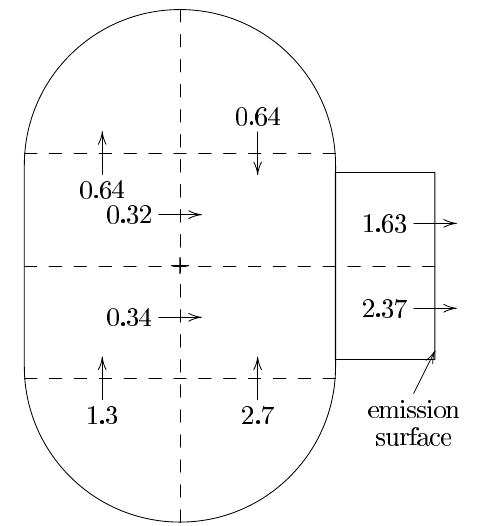
FIG. 8. Coarse-grained diagram of current flow in the cathode dome (units of kA). The emission surface is on the right.